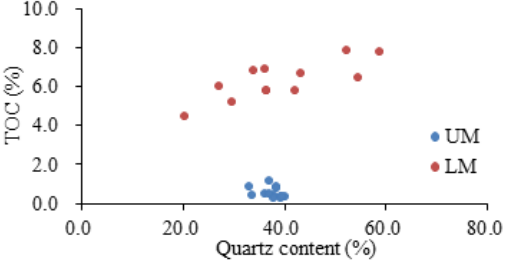
Figure 8. Relationship between TOC and quartz content.